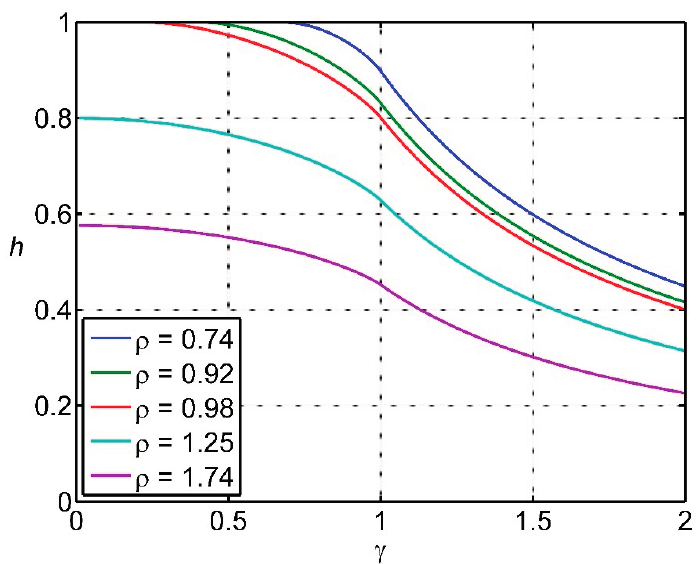
Figure 10. The fractional success rate h for hitting targets under different conditions of target size and platform speed.